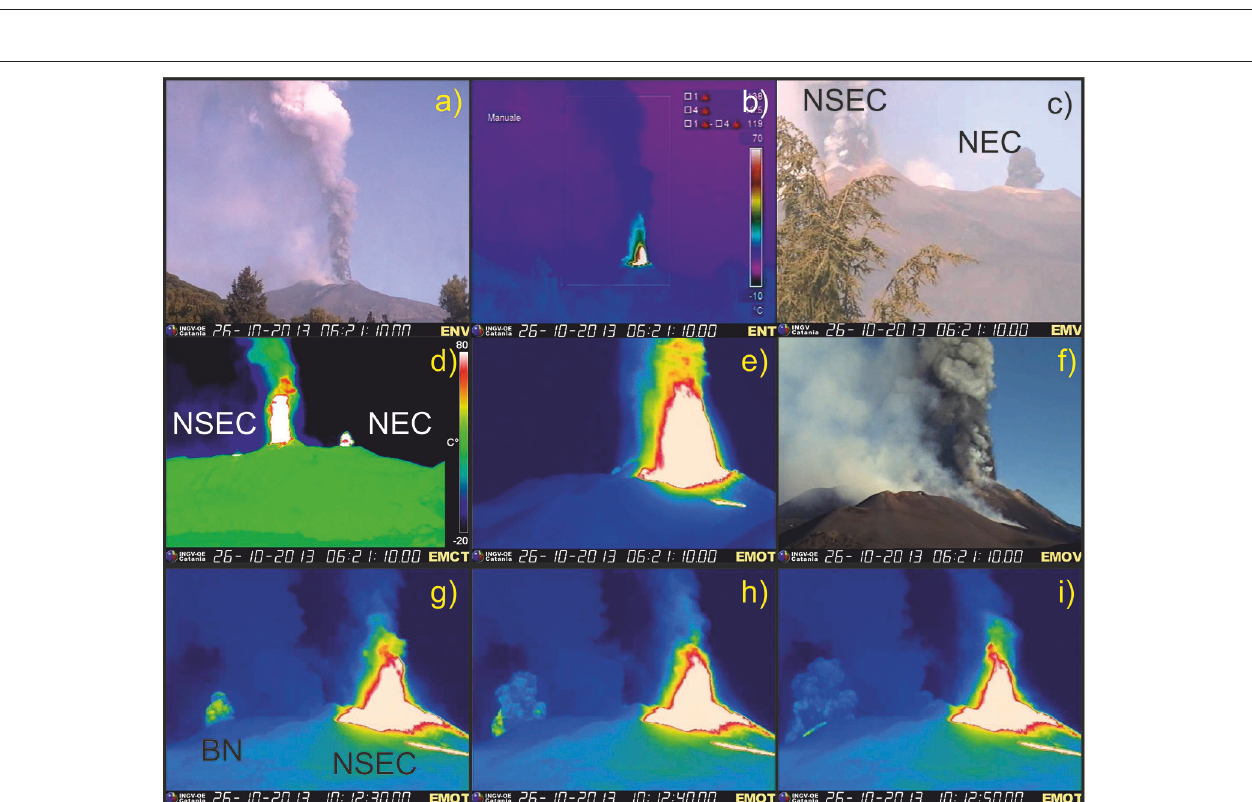
FIGURE 4 | (a) Lava fountaining activity as recorded by the INGV video-surveillance network: (a) Nicolosi visible camera (ENV), (b) Nicolosi thermal camera (ENT), (c) Milo visible camera (EMV) (d) Monte Cagliato thermal (EMCT), (e) Montagnola thermal camera (EMOT), (f) Montagnola visible camera (EMOV); (g,h,i) sequence of frames showing an explosion at the Bocca Nuova Crater (EMOT). Nicolosi and Montagnola cameras are recording from the S, the Milo camera from the SE and the Monte Cagliato from the E. Times are GMT (local time: + 2h). Frames (a,b,c,d,e,f) show the same eruption time (06:21).